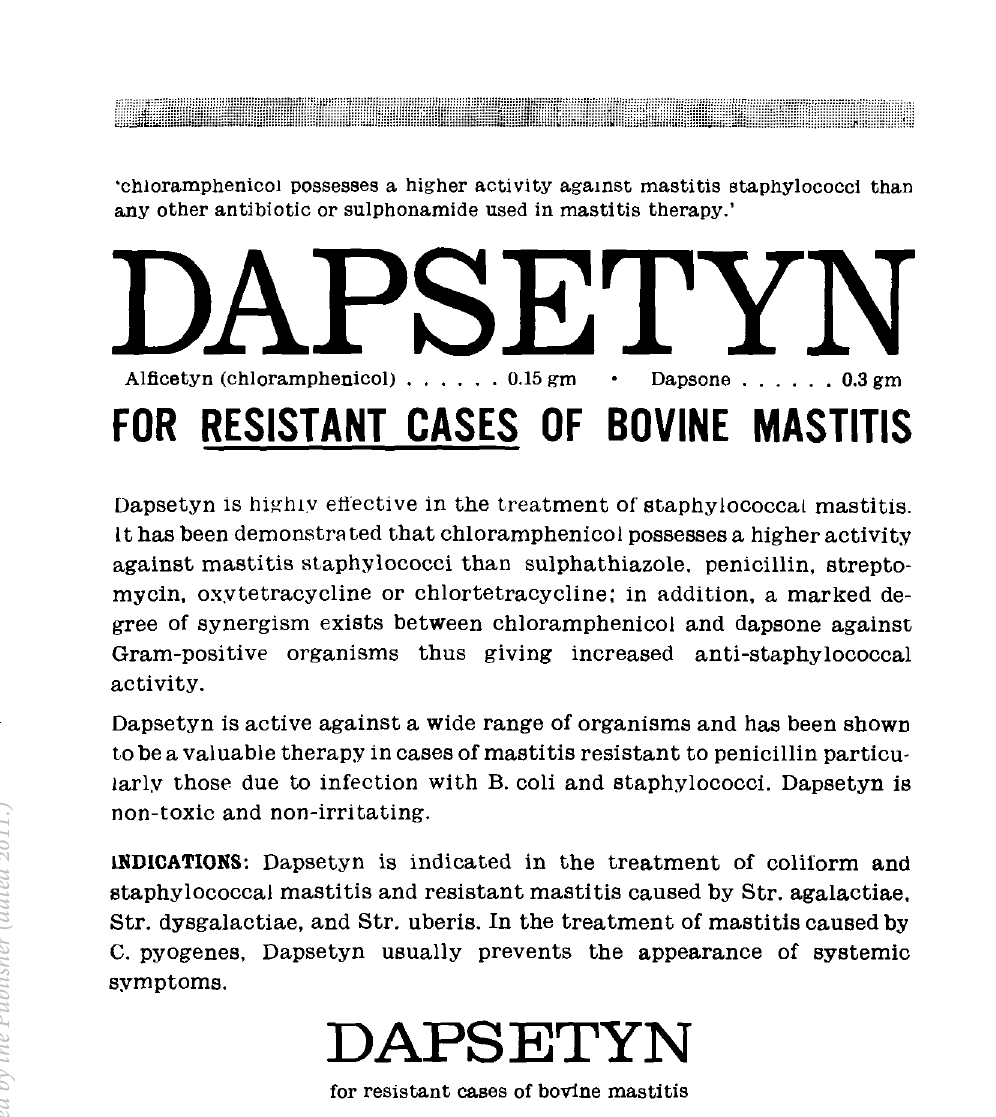
for resistant cases of bovine mastitis per carton of 12 tubes . R4.80 less usual professional